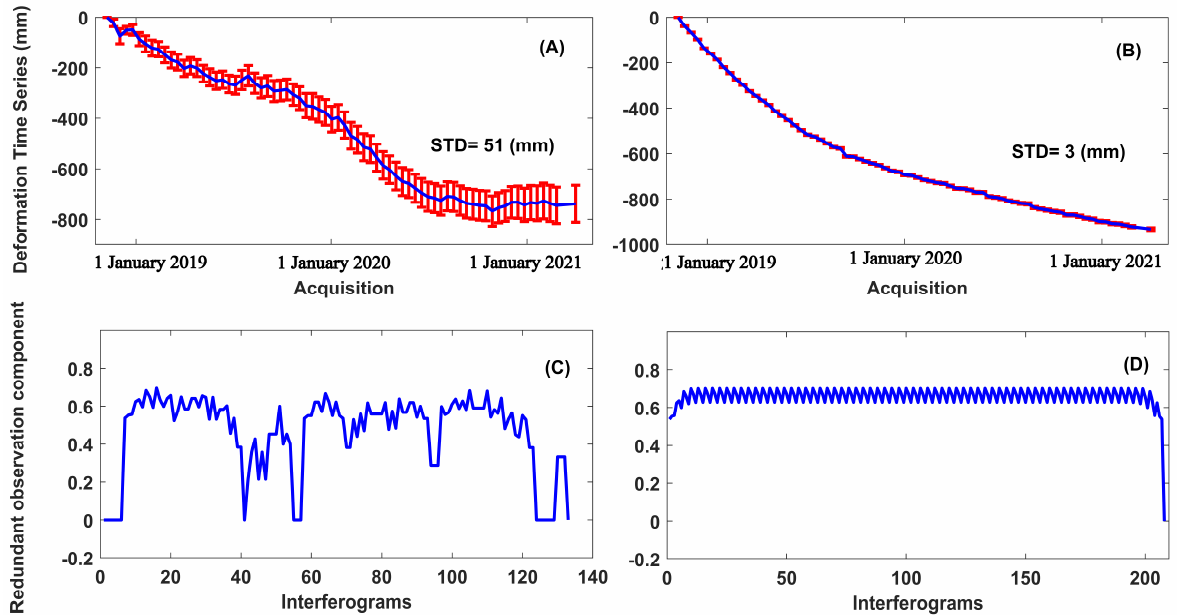
Figure 13. First and second columns correspond to pixels P1 and P2 of Figure 11A. ( A , B ) are the deformation time series; ( C , D ) are the redundant observation components.